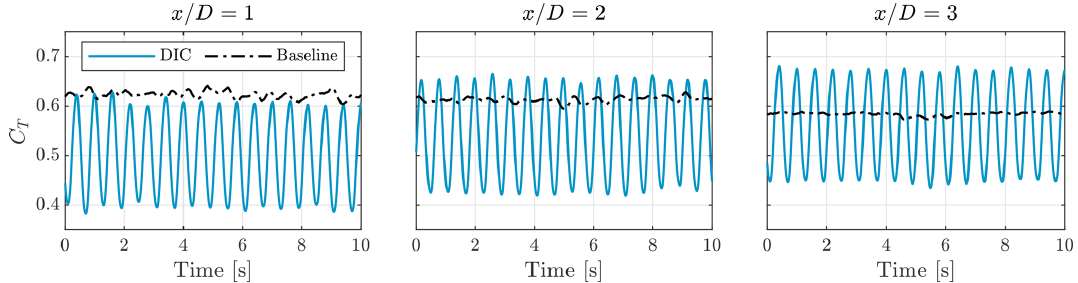
Figure 5. Thrust coefficient of the turbine for different measurement positions. The results are based on a single measurement for each distance using either baseline control or DIC with St = 0 .